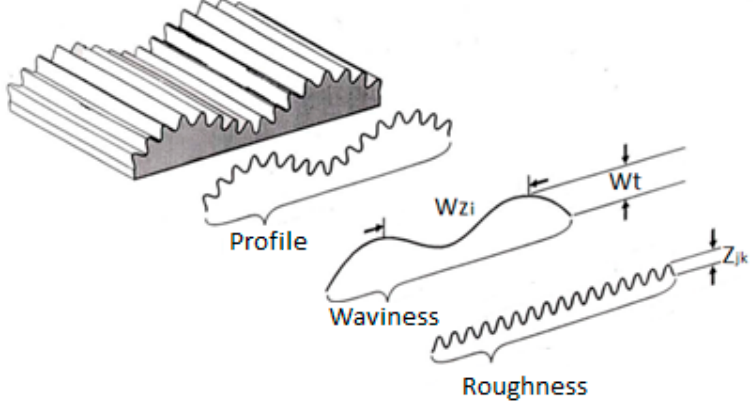
Figure 2. Display of waviness and surface roughness of the material [18]. Where Wt is the wave height, defined as the distance between the highest and lowest point of the wave W; Wz is the wavelength